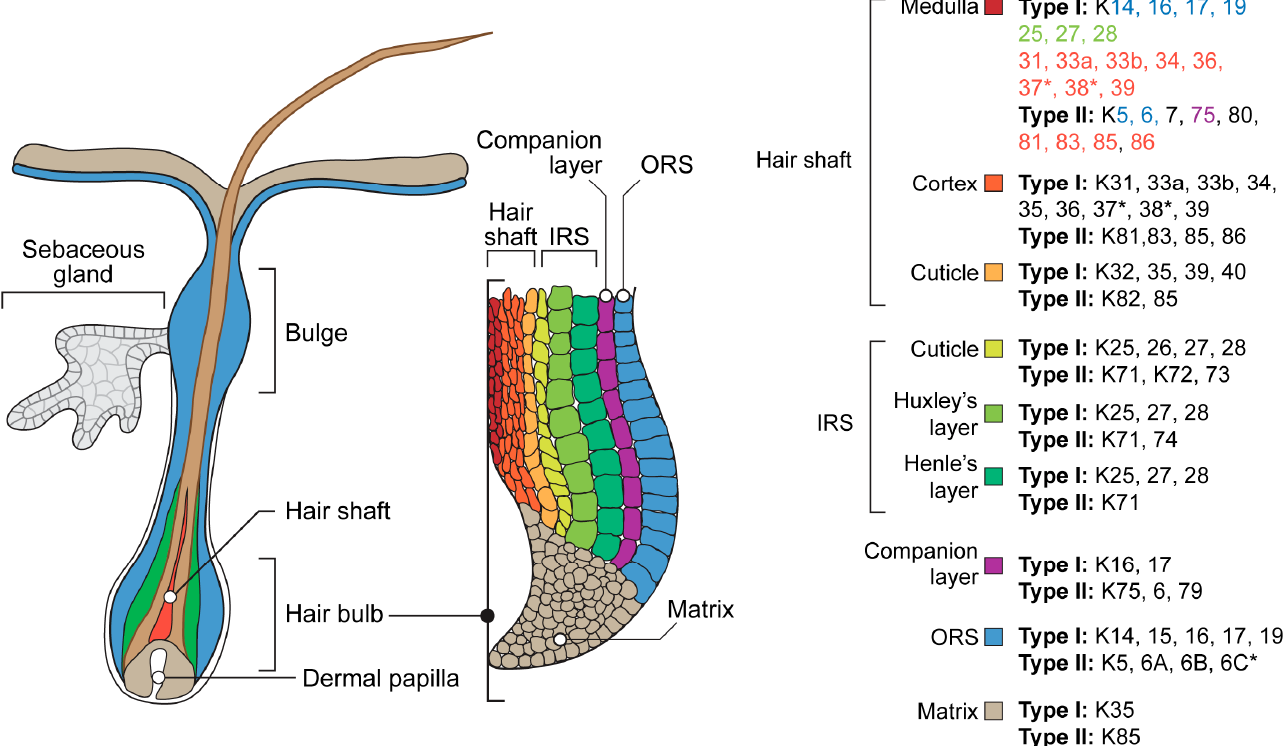
Figure 2. Schematic representation of the hair follicle and a list of keratins expressed in its internal structures. *—absent in the mouse genome. ORS—outer root sheath, IRS—inner root sheath. Note that keratins expressed in the medulla are colored according to their presence in other structures of the hair follicle [2,153,168,182–184].